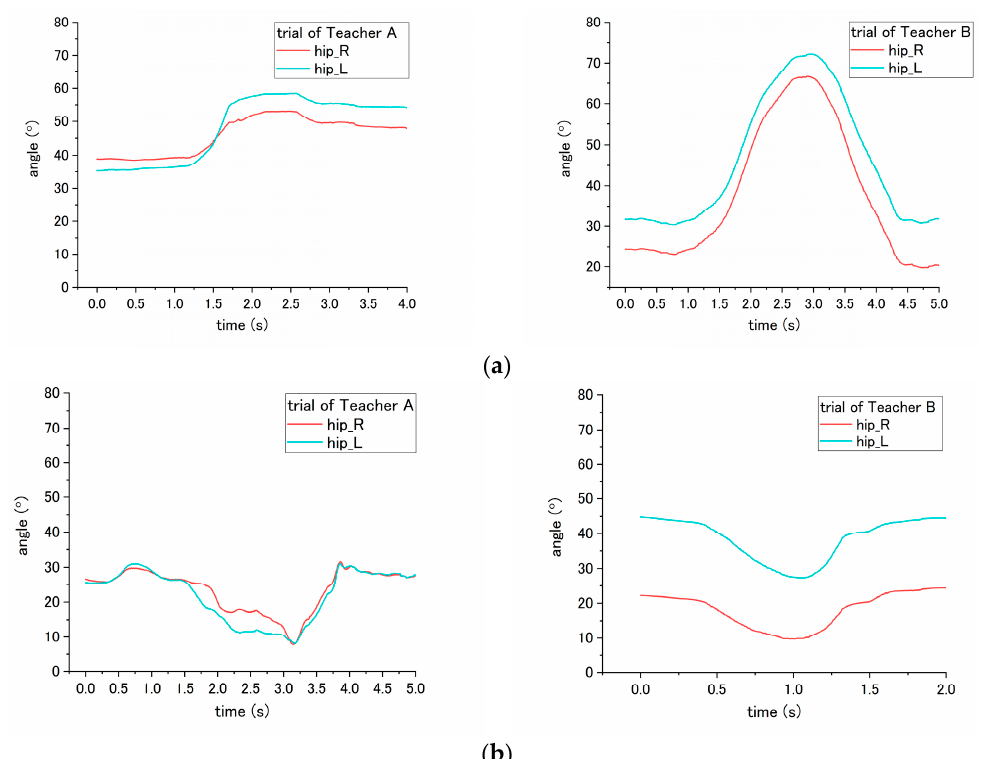
Figure 22. Flexion angle of patient’s hip during step No. 16 when the ( a ) correct way, and ( b ) incorrect way were conducted at step No. 16.